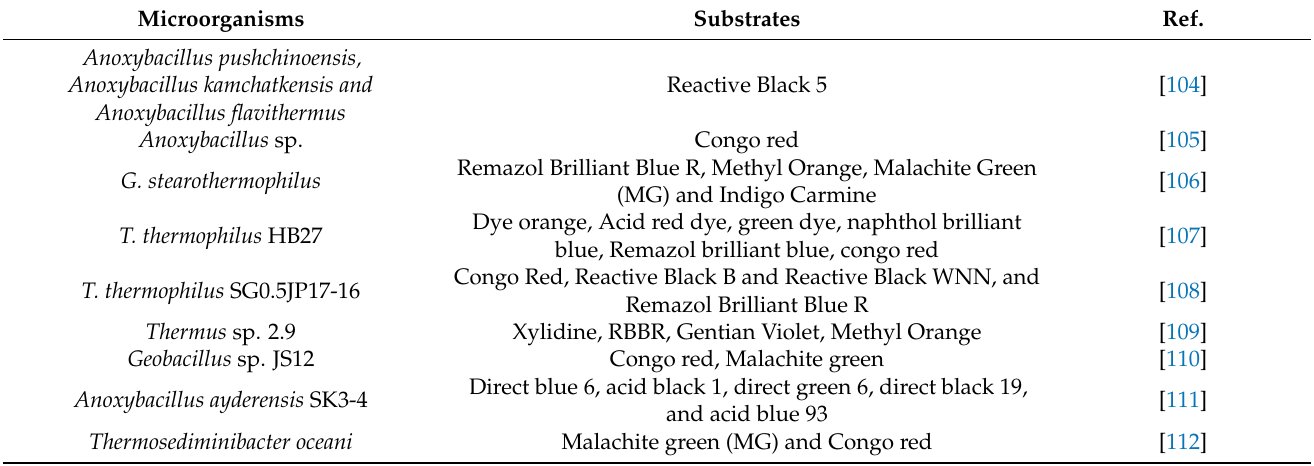
Table 3. Examples of dye-decolorizing